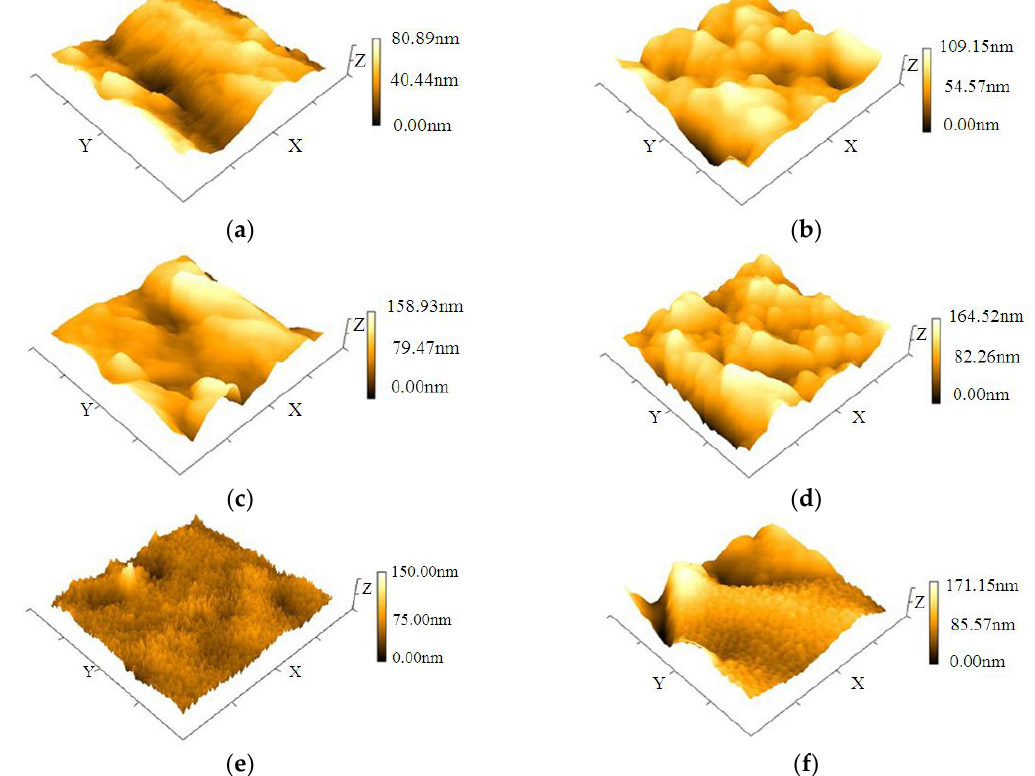
Figure 5. Surface profile of different structures on aluminum templates: ( a ) Al template; ( b ) MS 245A; ( c ) MS 300A; ( d ) MS 550BT; ( e ) AAO; ( f ) micro/nano-structure without electrolysis polishing.